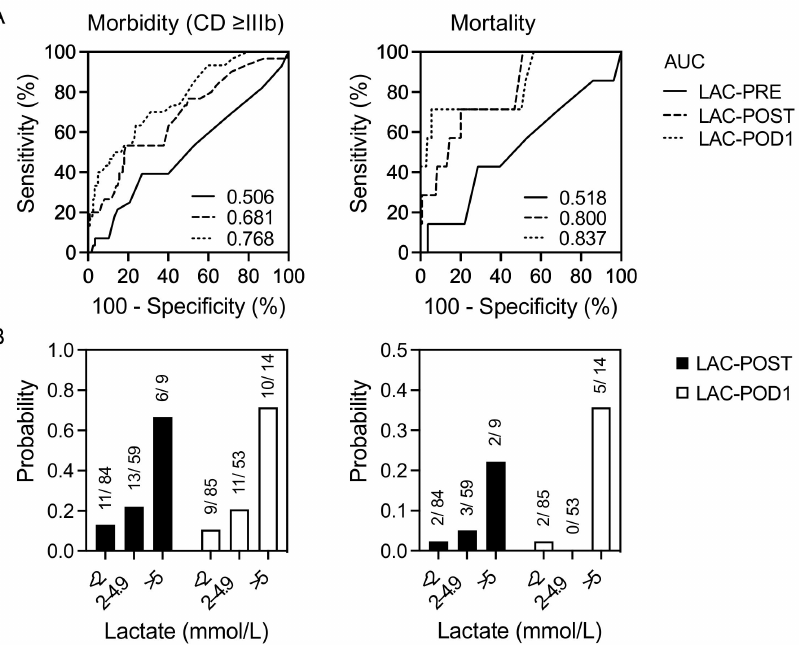
Figure 3. ROC curves and probability of perioperative lactate levels in predicting postoperative com- plications and mortality in 152 patients undergoing liver resection. Receiver operator characteristic (ROC) curves ( A ) for lactate as discriminators of the increased rate of postoperative morbidity and mortality. Probability ( B ) of postoperative morbidity and mortality according to lactate concentration. CD ≥ IIIb, Clavien–Dindo ≥ IIIb; LAC-POST, lactate after liver resection on day 0; LAC-POD1, lactate on day one after liver